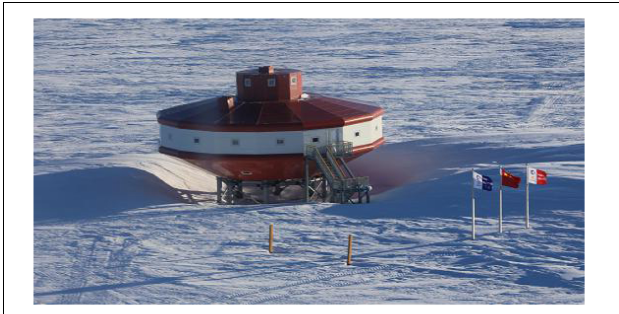
FIGURE 2 | Aerial view of the Taishan Station site, January